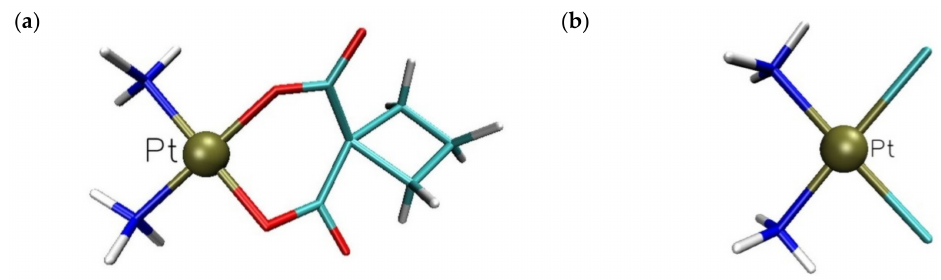
Figure 2. Structure of carboplatin ( a ) and cisplatin ( b ). The connection between DNA and carboplatin causes changes in DNA (Figure 3), which inhibits the process of DNA replication that generates replication errors, along with the accumulation of cells in the G2/M phase and induction of apoptosis [29]. The formation of connections between carboplatin and DNA strands causes cytotoxicity.